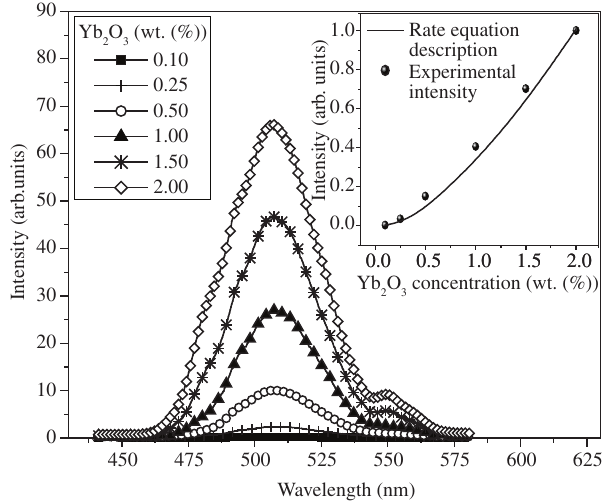
Figure 4. The cooperative luminescence for GP glass doped with different concentrations of Yb O . The inset shows the experimental (points) and 2 3 calculated (continuous line) cooperative emission intensity as a function of Yb O concentration. 2 3